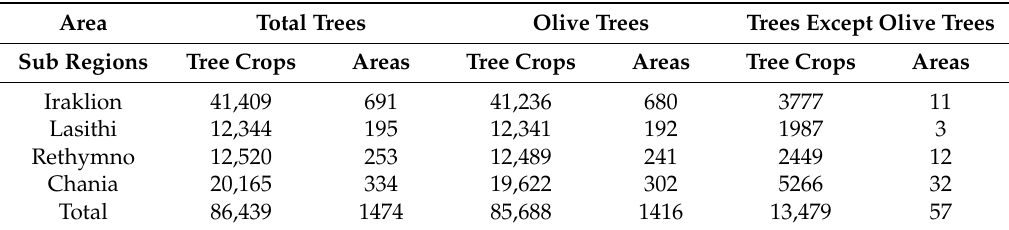
Table 3. Agricultural holdings in the region of Crete (land in thousands of acres) [60–62]. Total Trees Olive Trees Trees Except Olive Trees